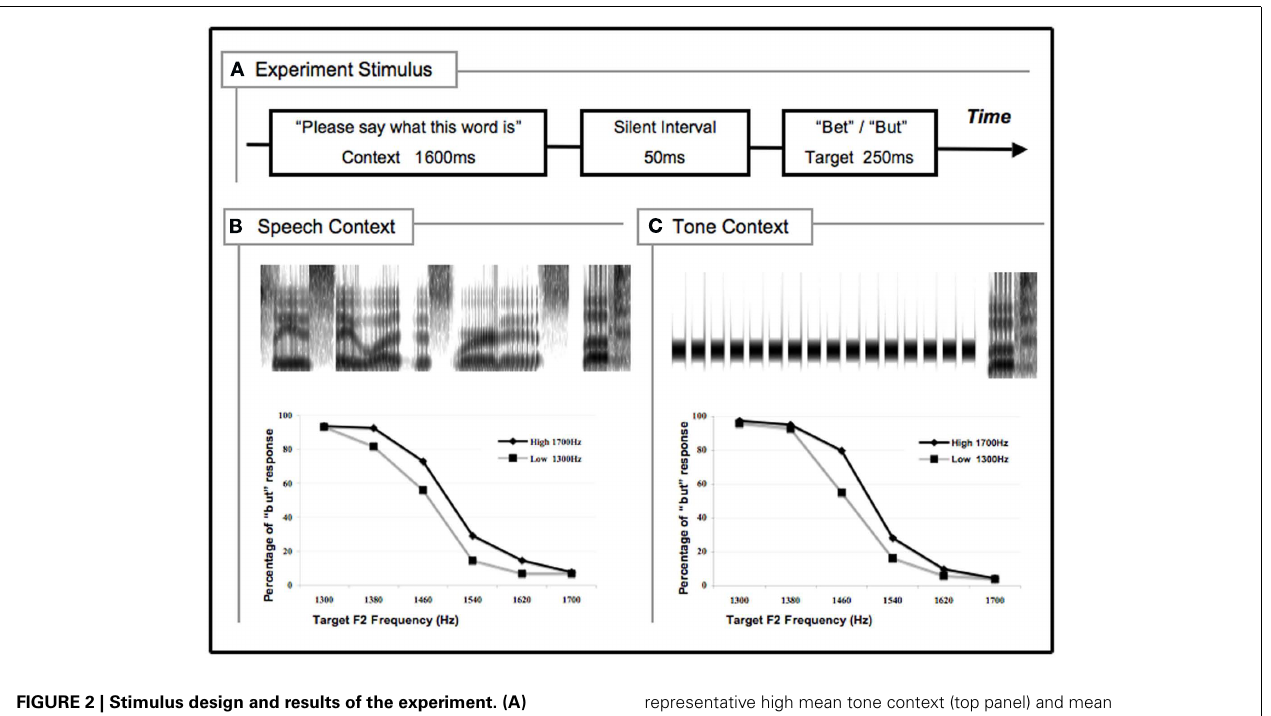
FIGURE 2 | Stimulus design and results of the experiment. (A) Schematic illustration of stimulus components; (B) spectrogram in time x frequency dimensions for the high mean speech context (top panel) and mean percentage of “but” responses in speech contexts (bottom panel); (C) spectrogram in time x frequency dimensions for a